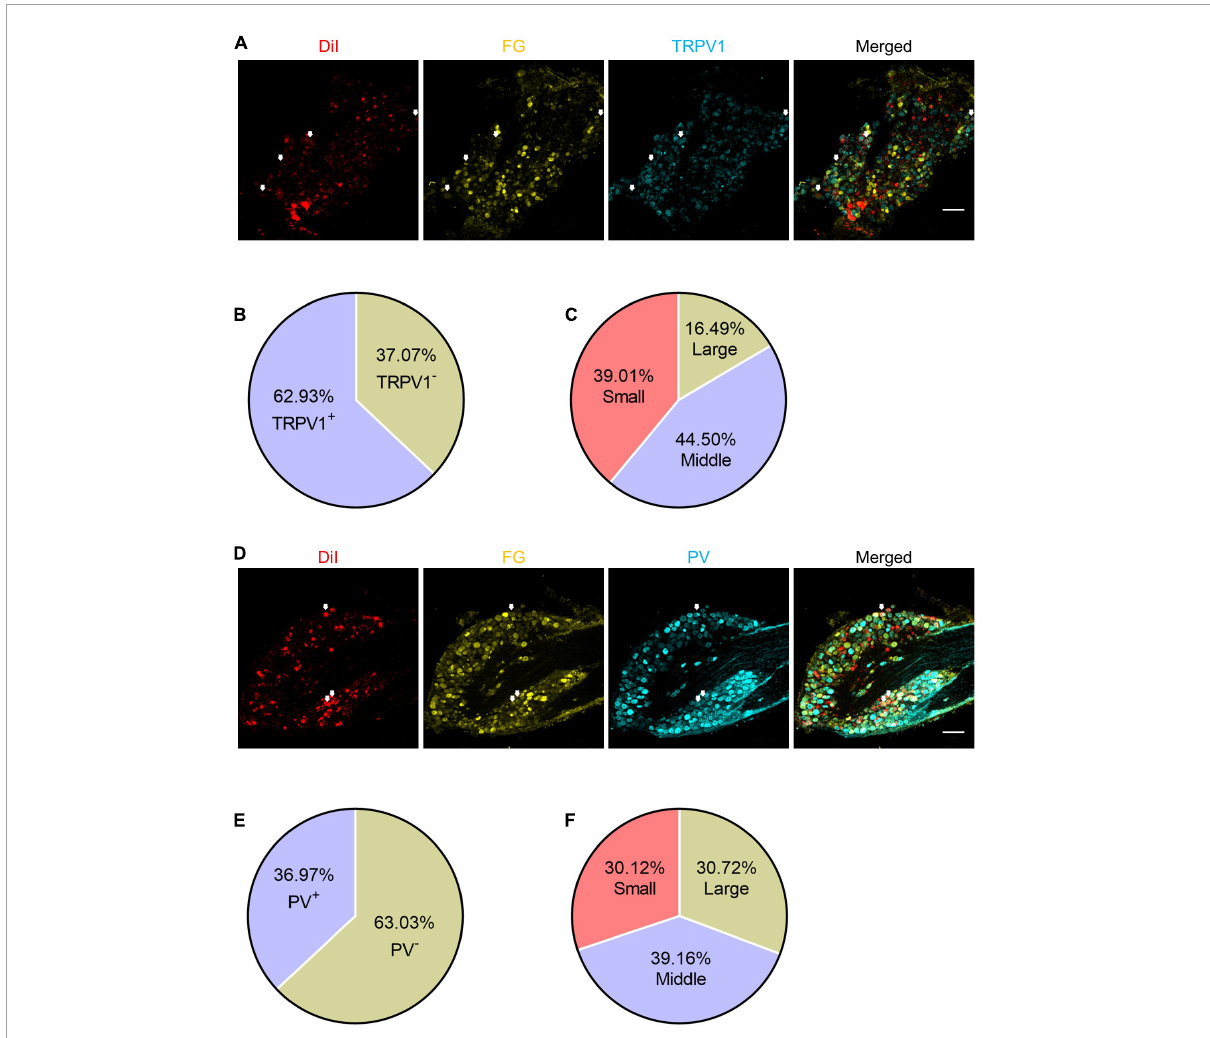
FIGURE7 The expression patterns of TRPV1 and PV in the shared DRG neurons. (A) The representative pictures of expression of TRPV1 in shared DRG neurons. FG, Fluoro-Gold. The white arrows indicate triple-labeled DRG neurons. Bar = 150 µ m. (B) The percentage of TRPV1 positive neurons in shared neurons. (C) The percentages of TRPV1 positive shared neurons with different diameters. (D) The representative pictures of expression of PV in shared DRG neurons. The white arrows indicate triple-labeled DRG neurons. Bar = 150 µ m. (E) The percentage of PV positive neurons in shared neurons. (F) The percentages of PV positive shared neurons with different